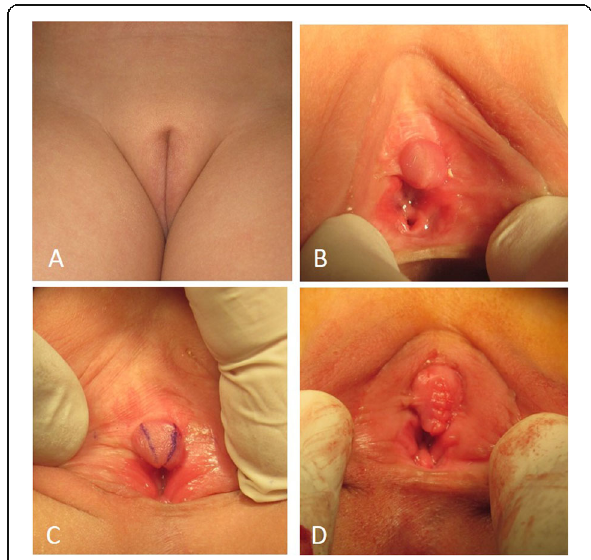
Fig. 10 Delayed complementary stage 12 months after the primary operation (feminizing genitoplasty). a Typical feminine appearance after primary operation. b – d Labial retraction revealed a well vascularized glans after reduction clitoroplasty; however, its larger than normal size was a major persistent concern for the parents that they requested further reduction to the size of the